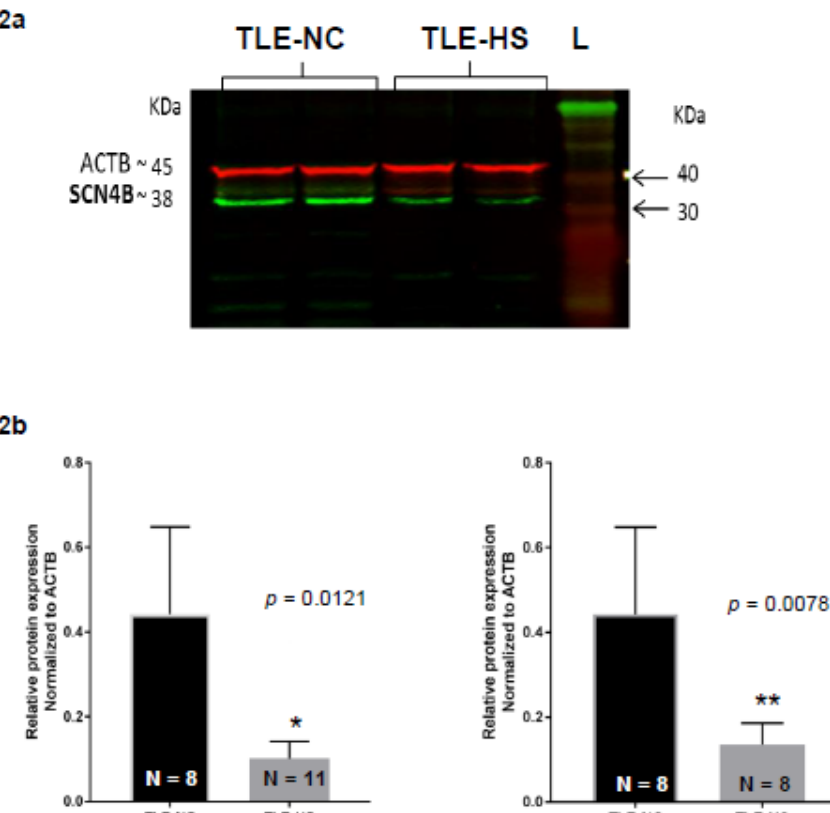
Figure 2. Qualitative example and quantitative Western blot analysis of β -actin and Nav β 4 protein expression in sclerotic and non-sclerotic samples of patients with AED-resistant TLE. ( a ) A Western blot analysis of Nav β 4 (37 kDa) and β -actin (45 kDa) in sclerotic and non-sclerotic hippocampal tissue. Protein extracts were run on SDS–polyacrylamide gels and analyzed by Western blotting. TLE-NC, non-sclerotic tissue; TLE-HS, hippocampal sclerotic tissue; L, Chameleon duo prestained protein ladder tissue. ( b ) Relative Nav β 4 protein expression level, compared to the β -actin control, as determine by densitometry. Data are means ± SD, where n = 8 for TLE-HS patients and n = 11 for TLE-NC controls.